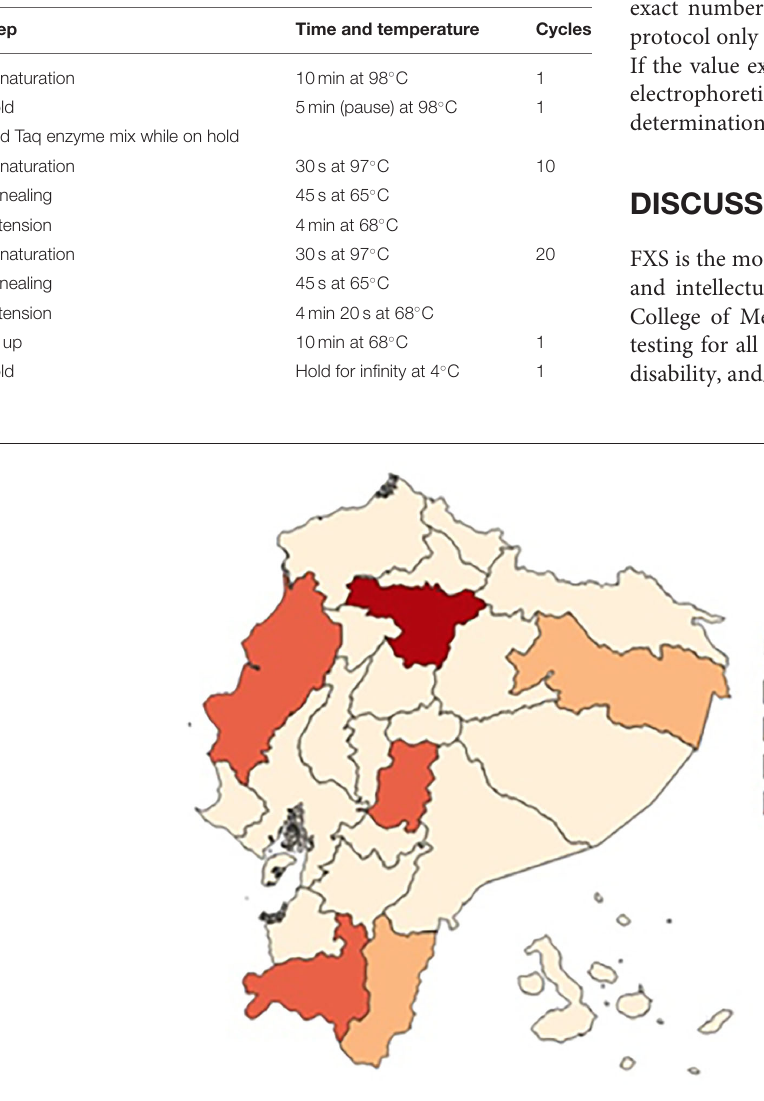
Frontiers in Psychiatry |